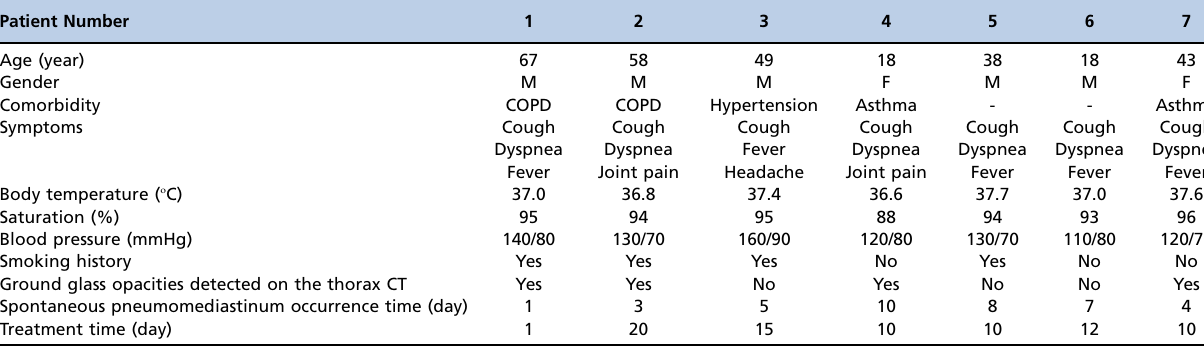
Table 1 - Demographic characteristics of